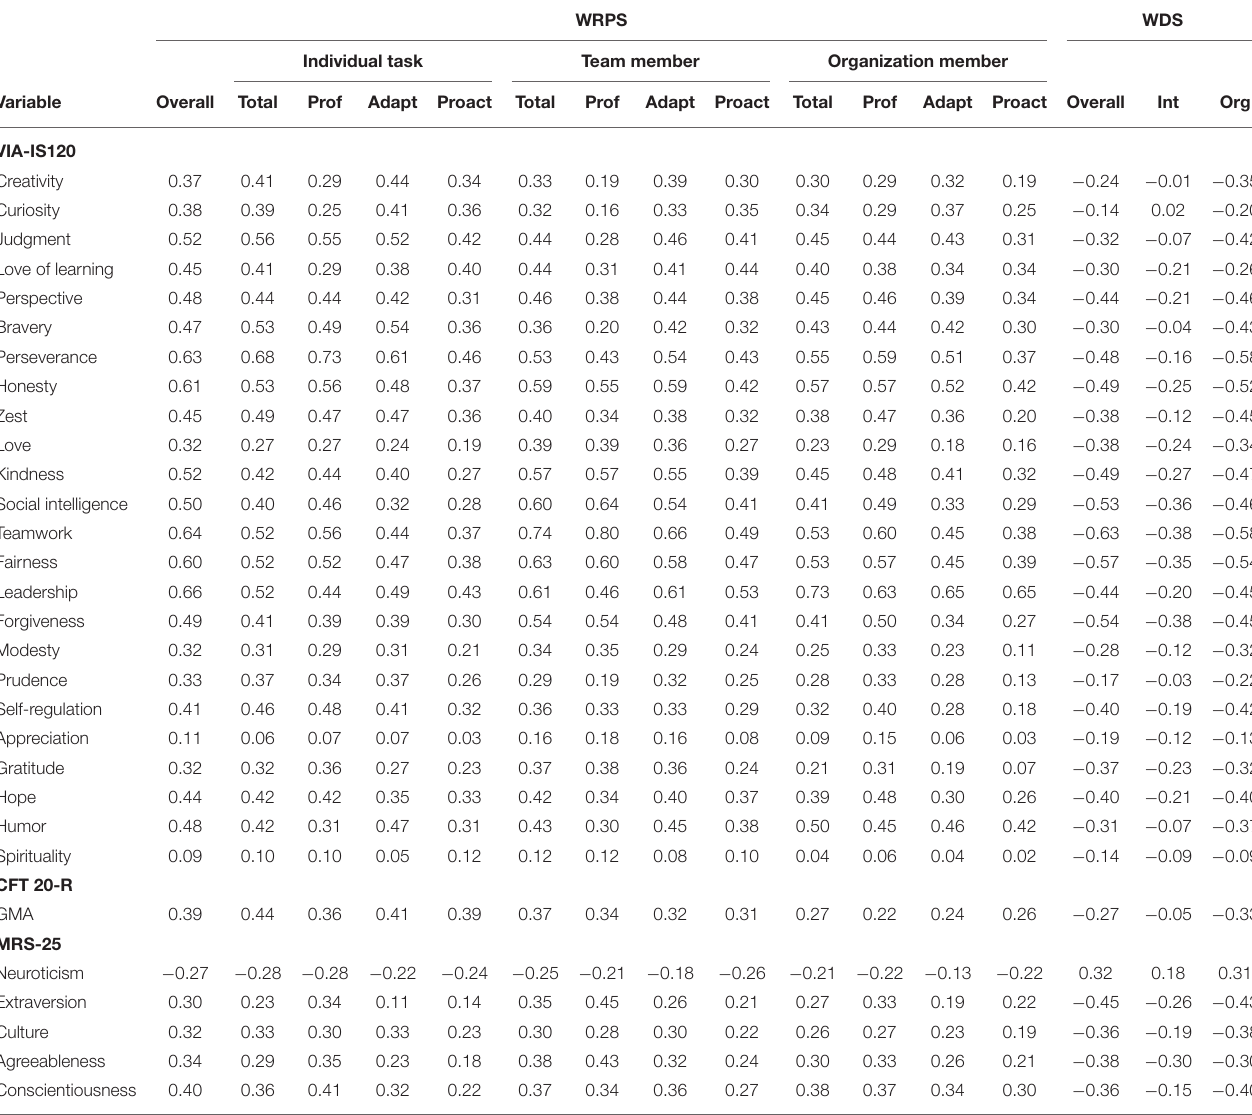
TABLE 4 | Partial correlations (controlled for employees’ sex and age) between employees’ self-assessed character strengths, GMA, and the Big Five (VIA-IS120 scales, CFT 20-R, MRS-25 scales) and supervisor ratings of employees’ productive and counterproductive work behavior (WRPS and WDS scales). WRPS WDS Individual task Team member Organization member Prof Adapt Proact Total Prof Adapt Proact Total Prof Adapt Proact Overall Int Org